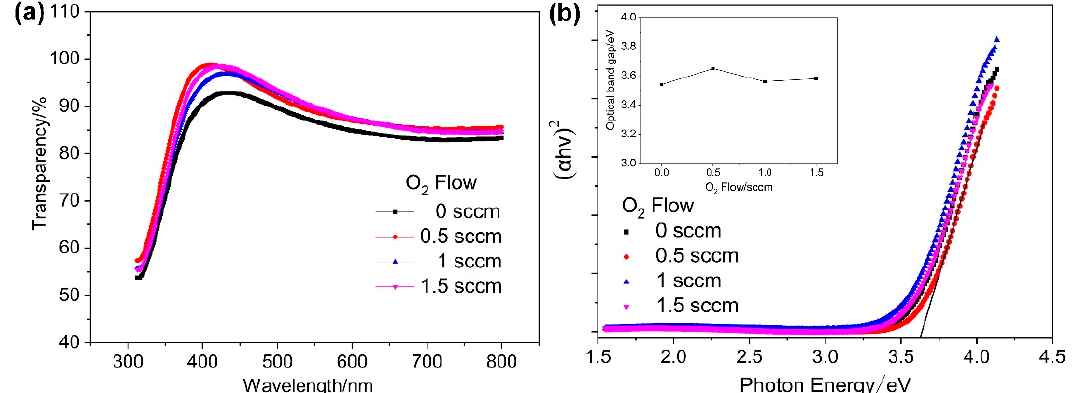
Figure 3. ( a ) Transparency of a-IGZO films under different oxygen flows; ( b ) the relationship between optical band gap and photon energy (inset shows the value of optical band gap).